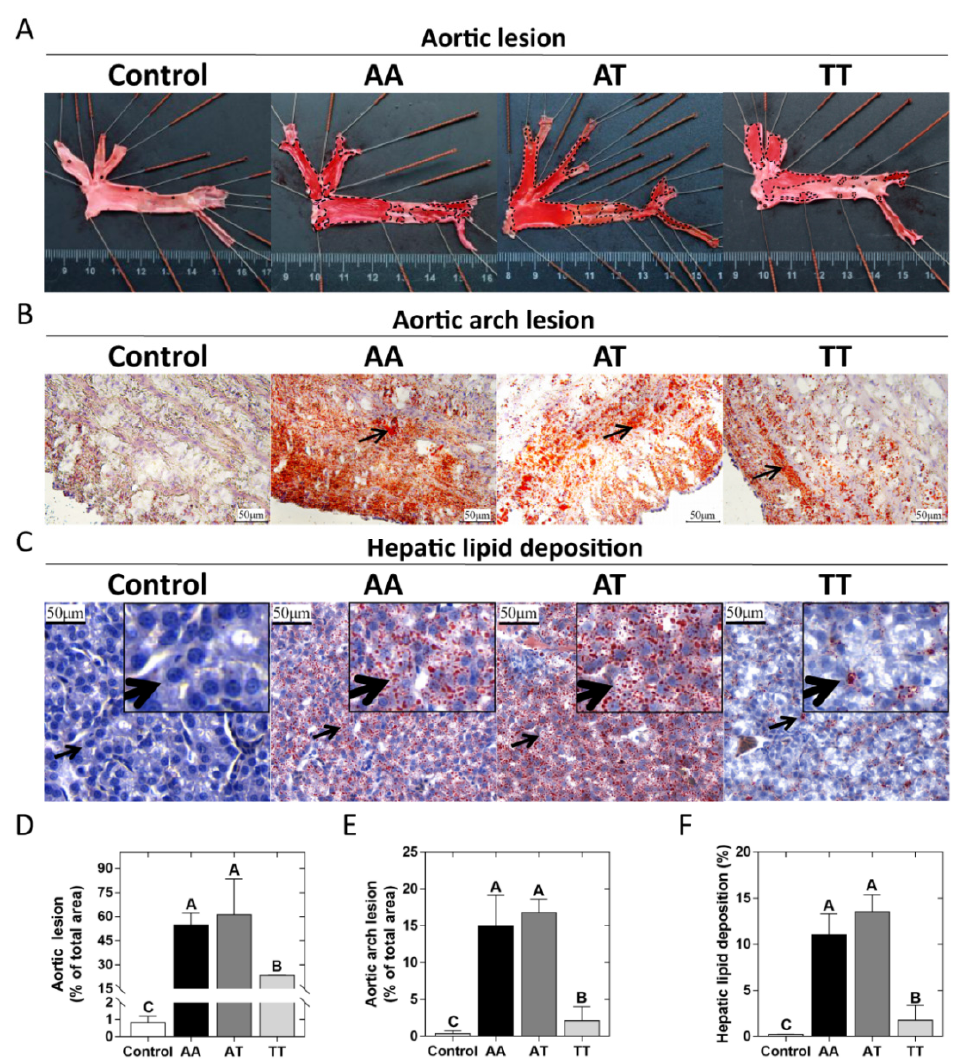
Figure 1. Pathological observations of lipid deposition in the aortic wall and liver in different genotyped chickens. ( A ) Oil Red O staining of the whole aorta with aortic lesions (black dashed lines). ( B ) Oil Red O and hematoxylin staining of aortic arch cross-sections, with arrows point to lipid droplets. ( C ) Oil Red O and hematoxylin staining of liver sections, with arrows point to local tissue magnification. ( D – F ) Quantification of staining results (% of total area) of the aorta, aortic arch cross- section, and liver (corresponding to A – C ), respectively. Values are expressed as means ± SD, n = 6 hens each genotype. A,B Means within a histogram with no common superscripts differ significantly ( p < 0.01).